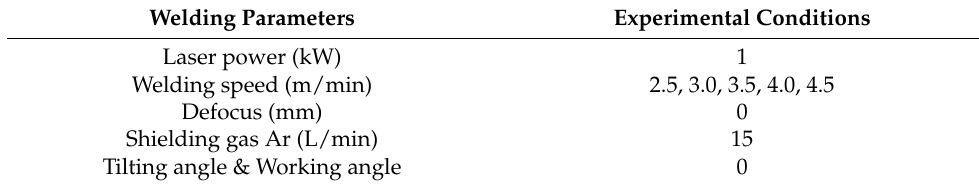
Table 5. 3rd Conditions of laser welding for 0.2 mm thickness of ASTM F1684.